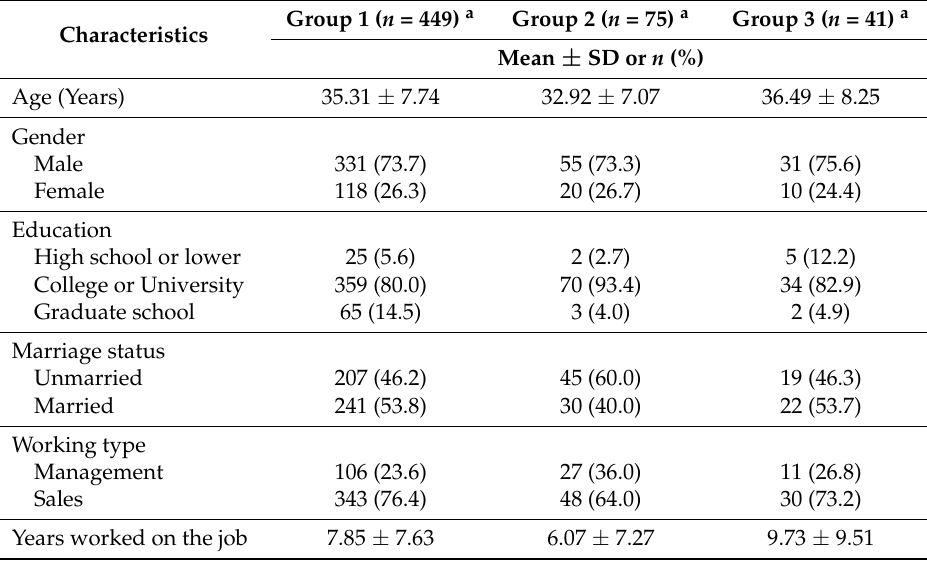
Table 2. Baseline general characteristics of the study